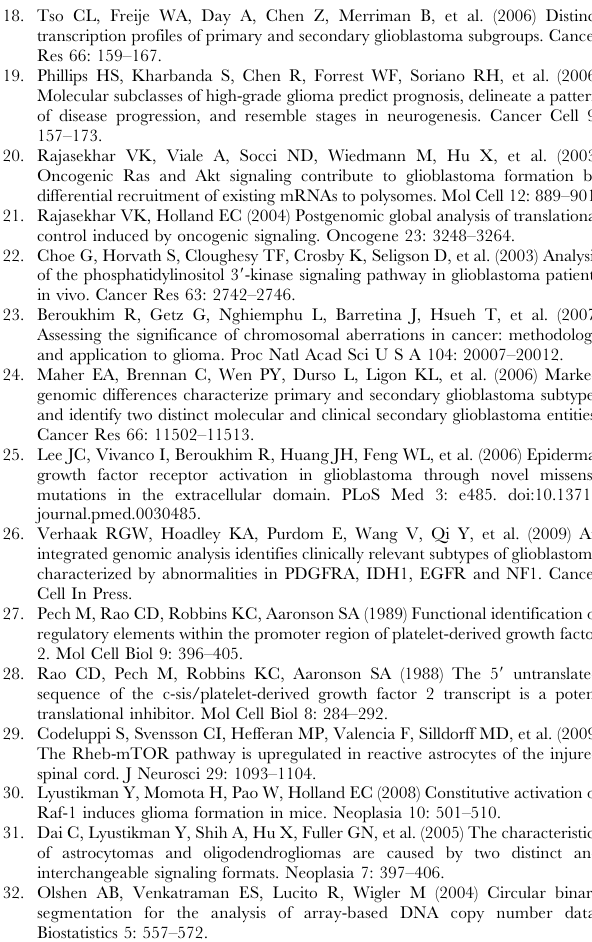
Table S3 Summary of integrated analysis of genomic data from 278 samples in The Cancer Genome Atlas. In this table, mutations are denoted in blue and designated ‘‘validated’’ and ‘‘unvalidated’’ according to whether TCGA reports that the mutation was verified by second sequencing method or whether such verification